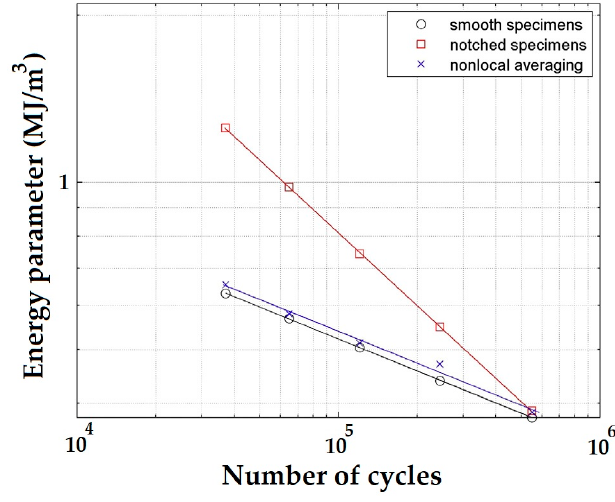
Figure 13. Energy parameter evaluation of 10HNAP steel